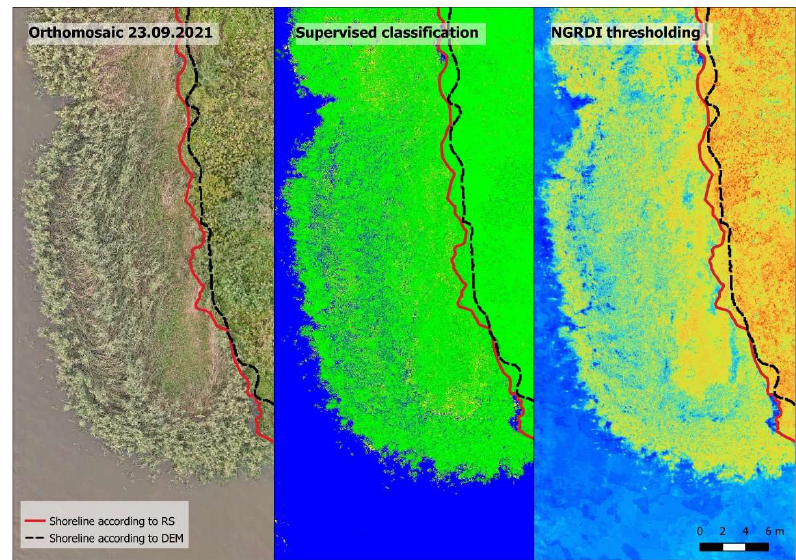
Figure 6. Shoreline detection in the areas containing high-density aquatic vegetation.